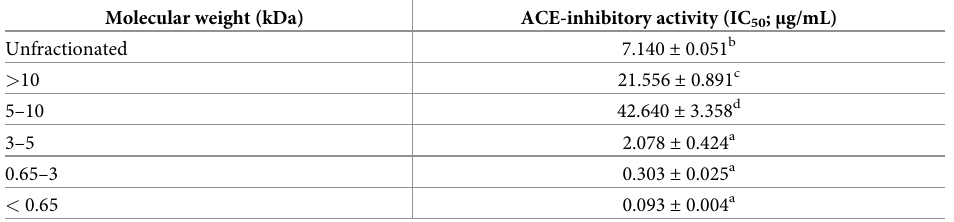
Table 5. ACE-inhibitory activity (IC 50 ) of the unfractionated trypsin hydrolysate and the five fractions obtained via ultrafiltration. Molecular weight